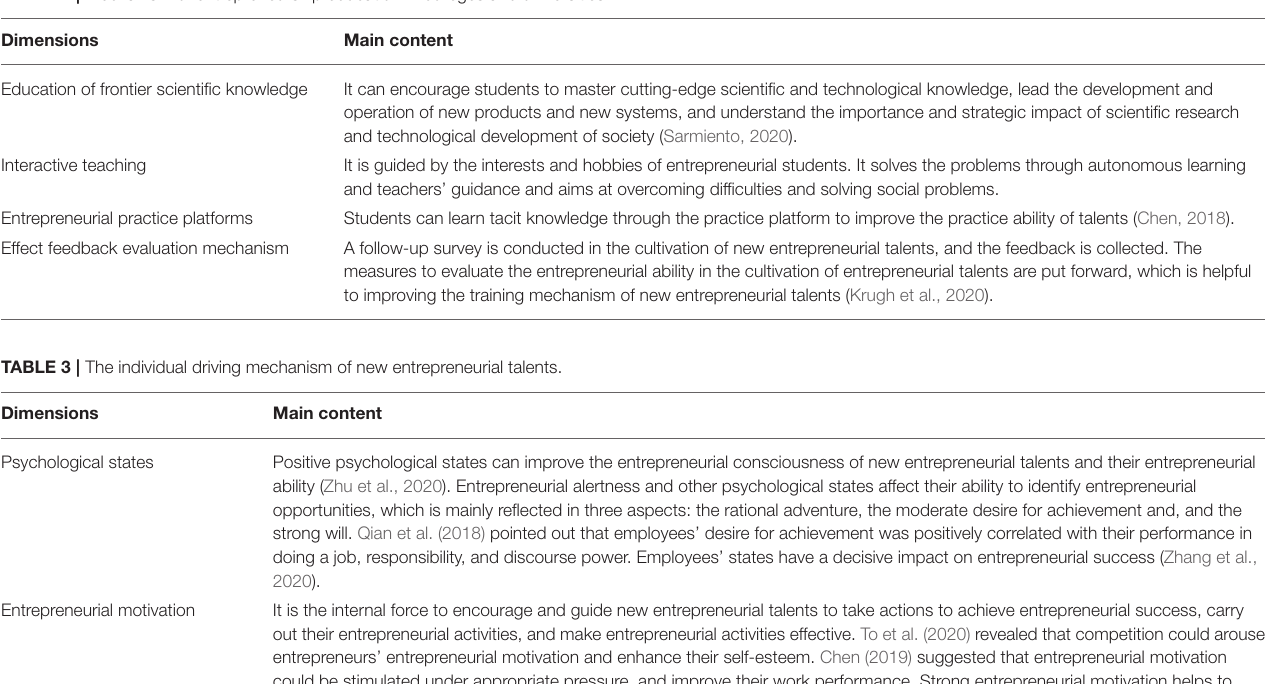
TABLE 2 | Mechanism of entrepreneurship education in colleges and universities.